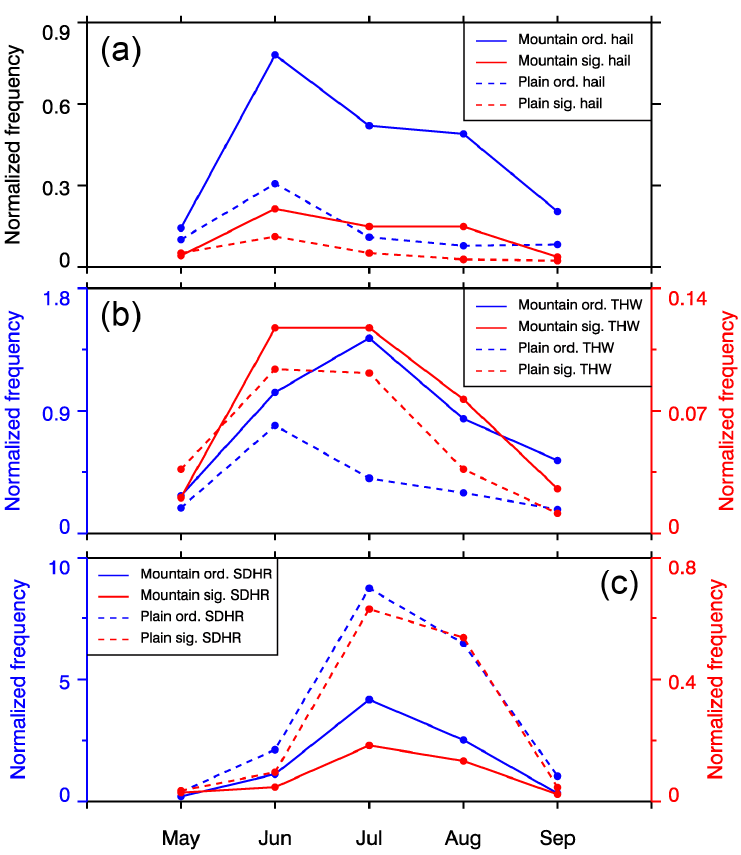
Figure 6. Monthly variation of the normalized occurrence frequencies of ( a ) hail, ( b ) THW, and ( c ) SDHR events of varying altitudes and severities during the warm seasons of 2011–2018 over North China. Solid (dashed) lines represent severe convective events over the mountains (plains). Blue (red) lines represent ordinary (significant) events.